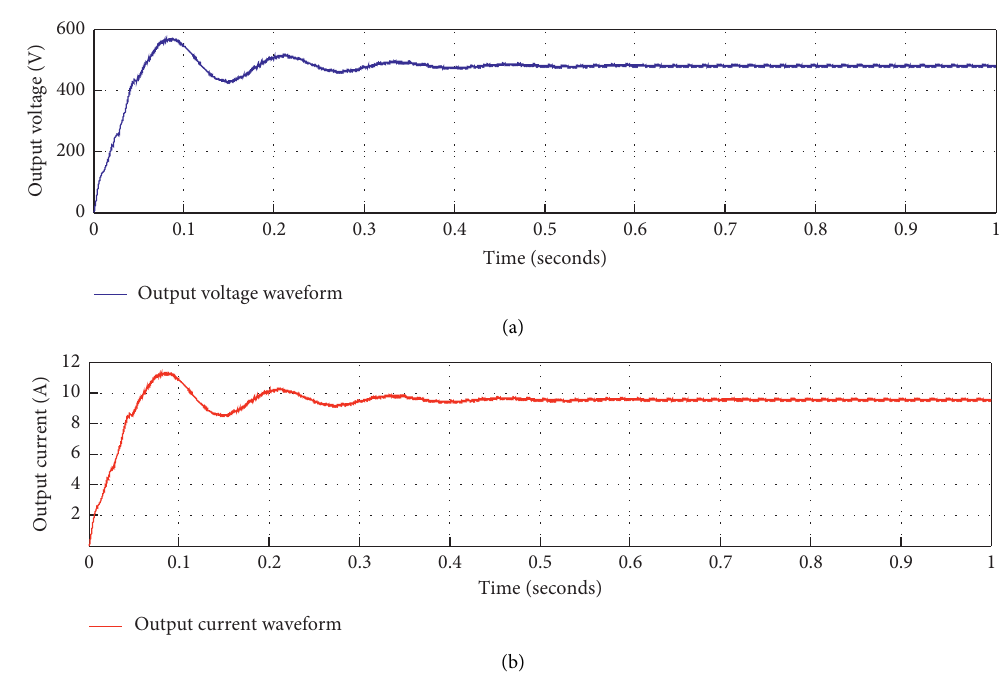
Figure 11: (a) Output voltage versus time and (b) output current versus time.